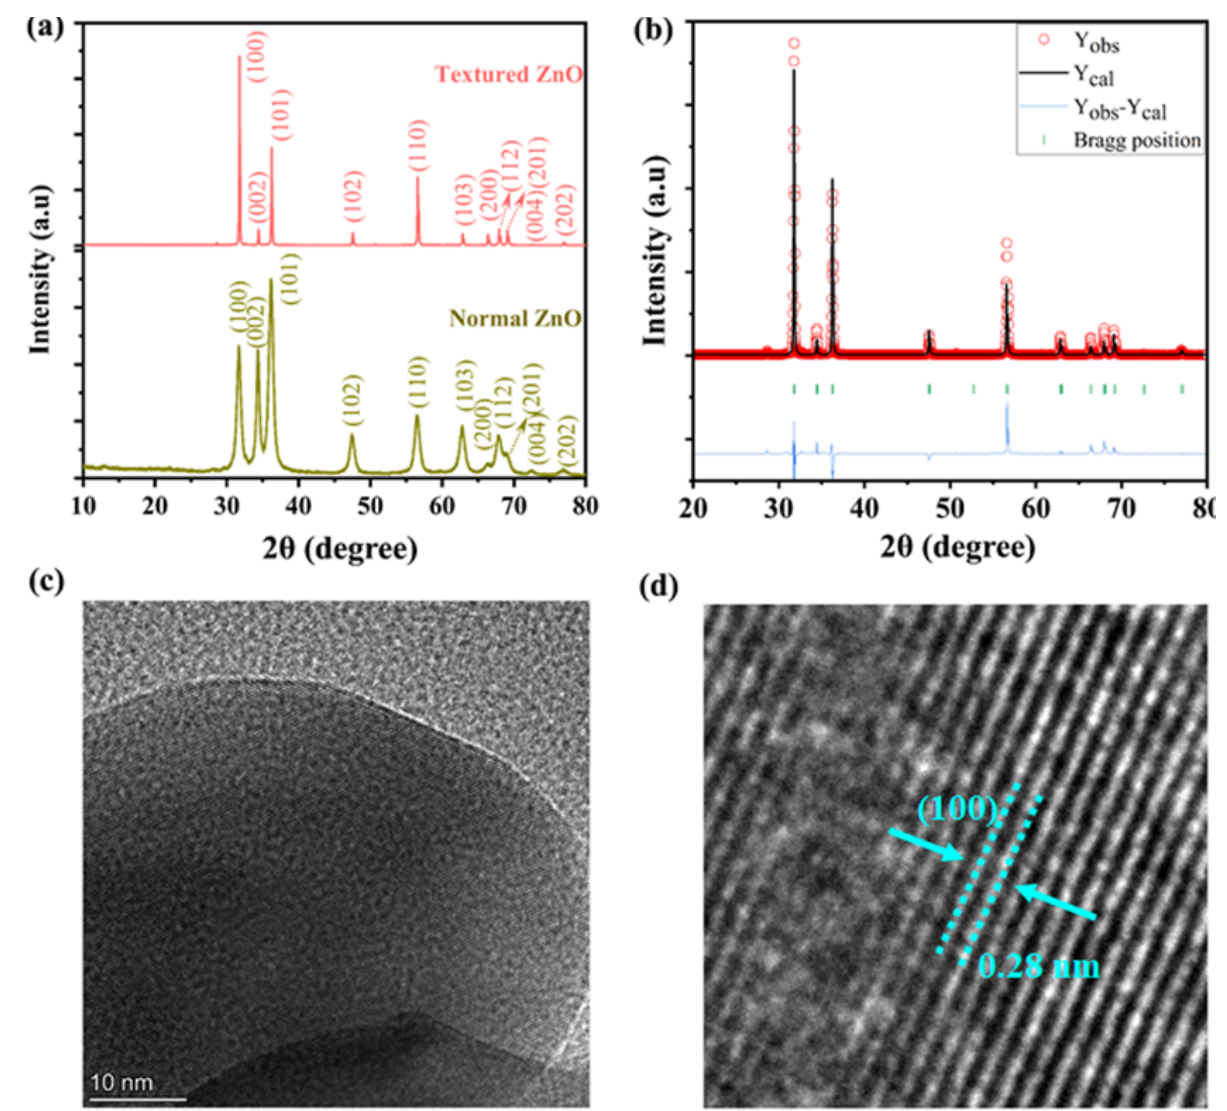
Figure 1. ( a ) X-ray diffraction patterns of synthesized nanoparticles ZnO ( b ) after heating in the H 2 atmosphere and ( c , d ) the crystal structure and d-spacing of the reduced ZnO particles measured via HR-TEM.